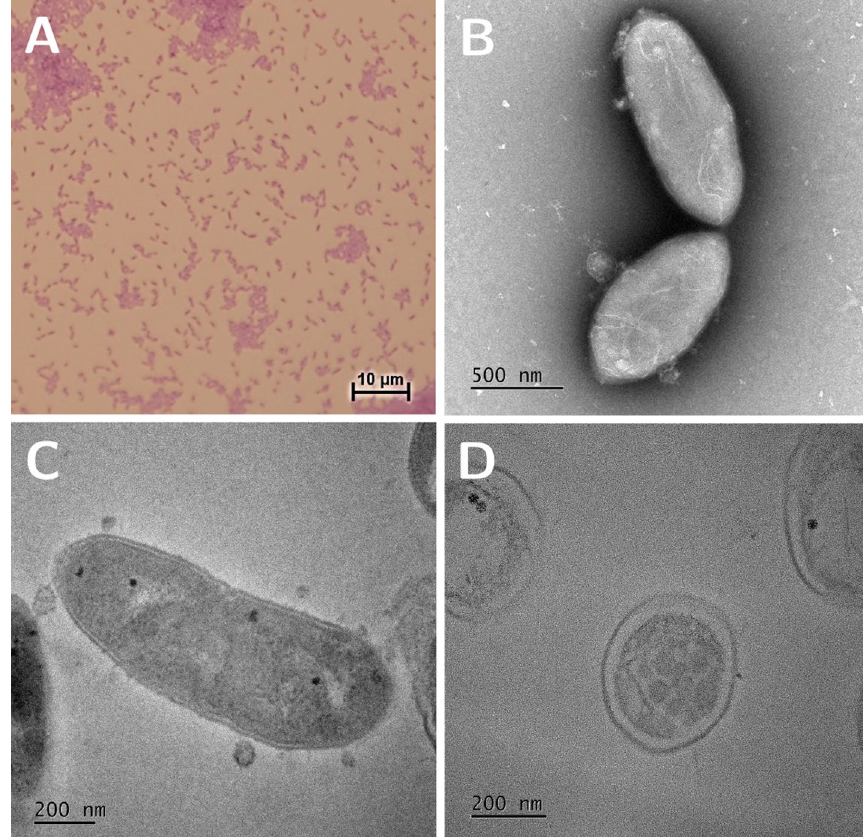
Figure 7. Representative pictures of C. minuta DSM 33715 ( C. min 22). ( a ) Gram staining of DSM 33715; ( b – d ): transmission electron microscopy acquisition of DSM 33715 after simple negative coloration ( b ) or after resin embedding showing a longitudinal section ( c ) and a transversal section ( d